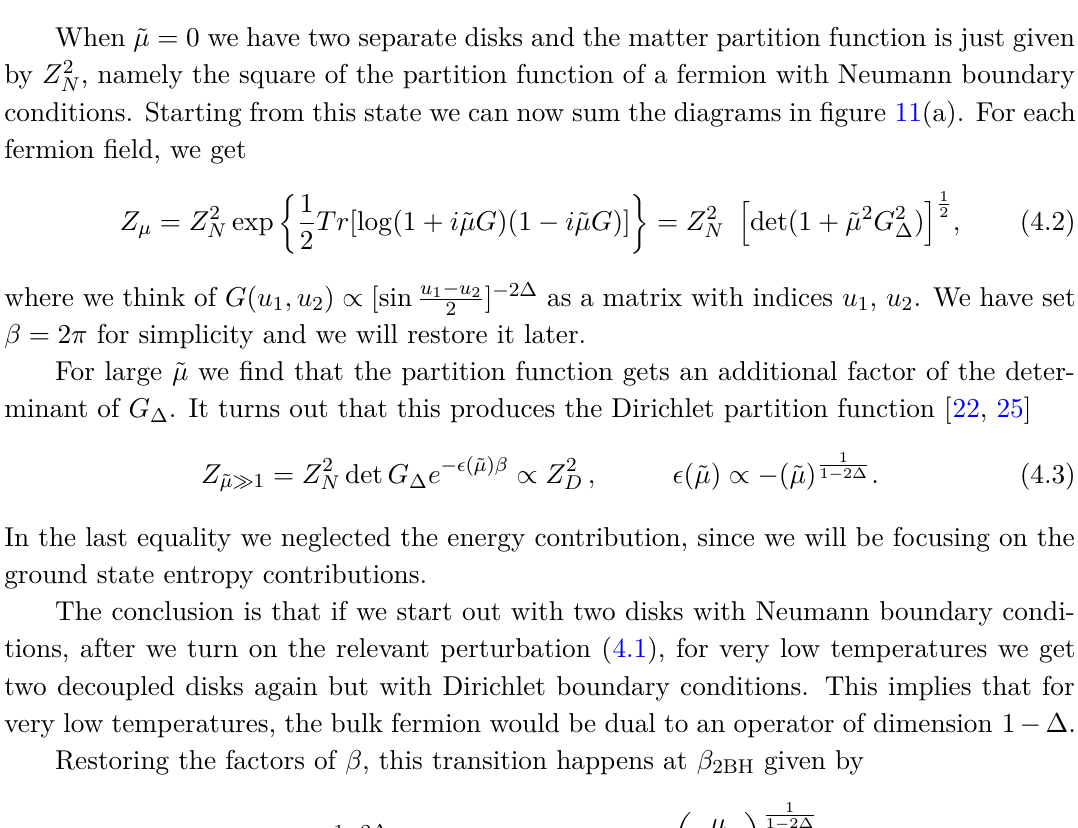
Figure 11 . (a) Field theory diagrams when we add an interaction term i ˜ µχ L χ R at the boundary of two disks. Here we picture one disk and the second as the outside. So χ L χ L propagators are the ones inside the disk and χ R χ R are outside the disk. (b) Diagrams in the two coupled SYK model that reproduce the field theory diagrams in (a). (c) An example of a diagram in the two coupled SYK model that is not present in field